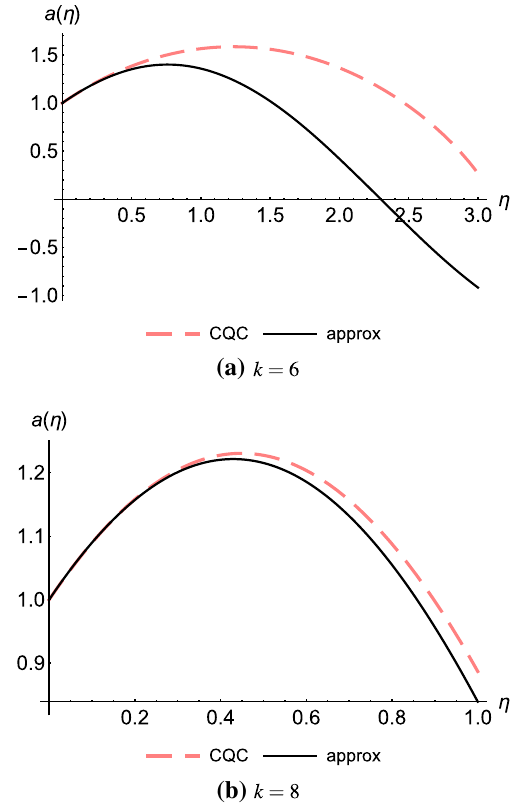
Fig. 5 Scale factor obtained using Eq.(105) and the CQC for k = 6 and k = 8 with a 0 = 1 and h =